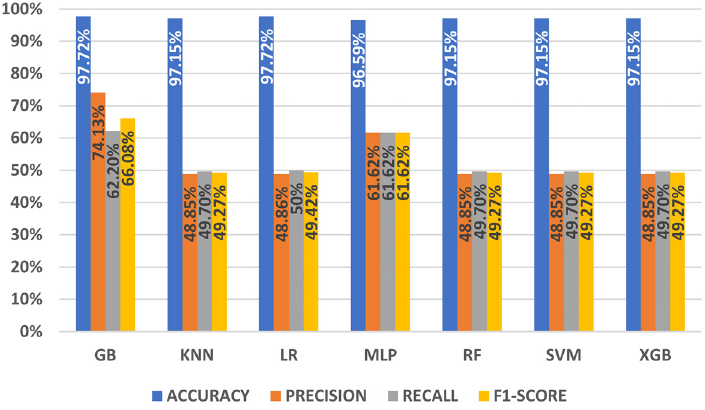
Figure 5. Histograms of the performance of our seven ML models on our REAL-880 test set.